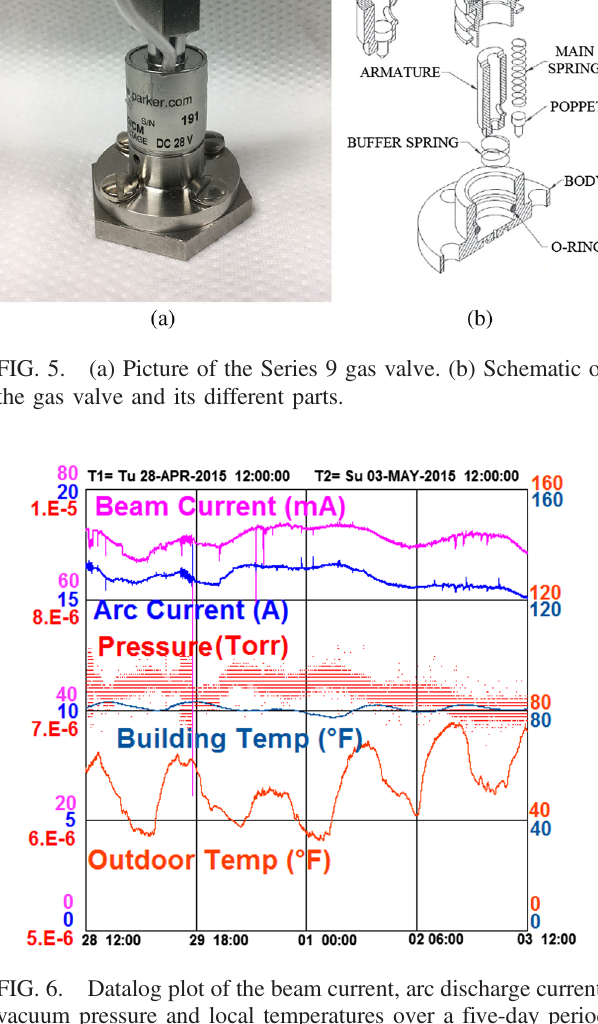
FIG. 6. Datalog plot of the beam current, arc discharge current, vacuum pressure and local temperatures over a five-day period using the piezoelectric gas valve in the source.